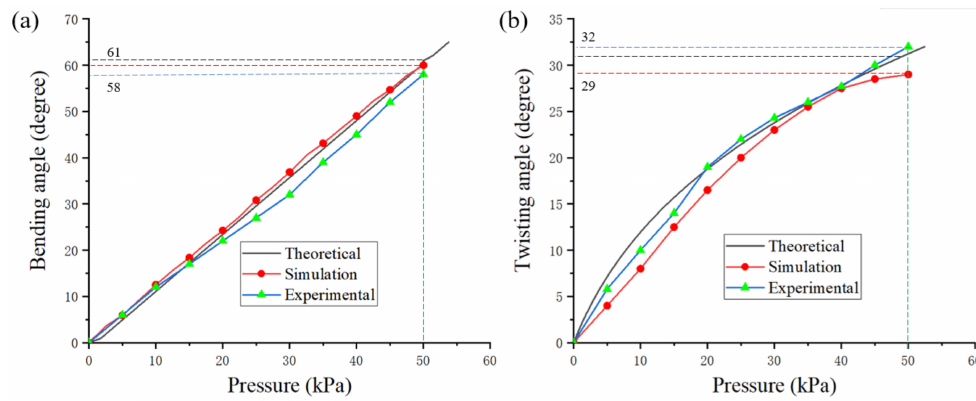
Figure 8. Theoretical, simulation, and experimental results for the soft wrist: ( a ) bending angle; ( b ) twisting